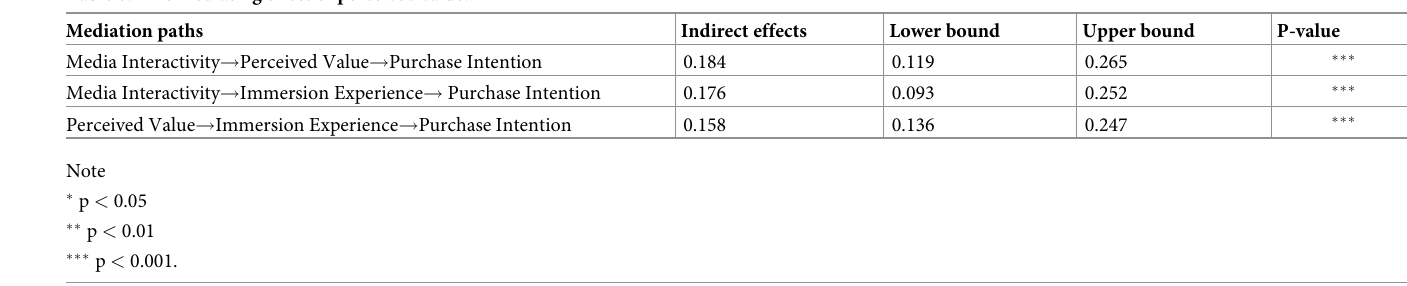
Table 6. The mediating effect of perceived